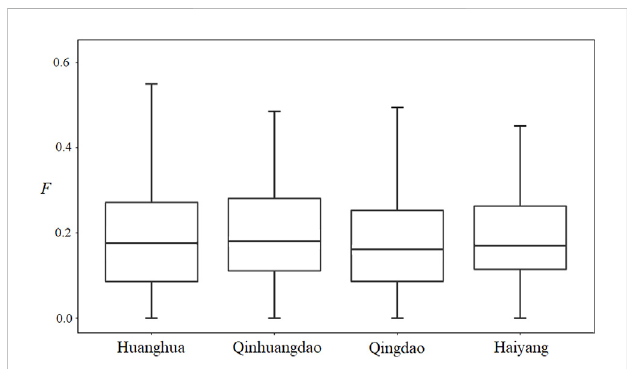
FIGURE 2 Individual F distribution of Fenneropenaeus chinensis in the four